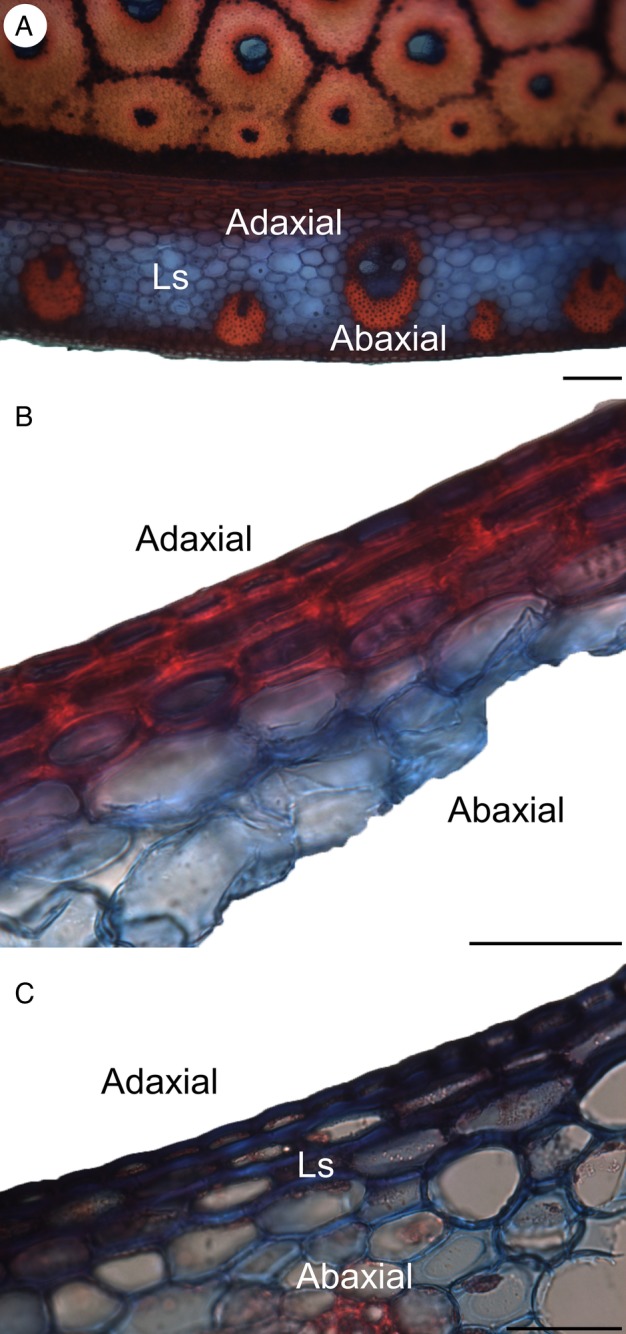
Developmental changes in the leaf sheath. (A) Close contact of leaf sheath and stem of developmental stage G2. (B) Lignification of leaf sheath tissue orientated towards the stem. (C) In younger stages, no lignification at the adaxial side of leaf sheaths is observed. Ls, leaf sheath. Scale bars are (A) 100 µm; (B and C) 50 µm.